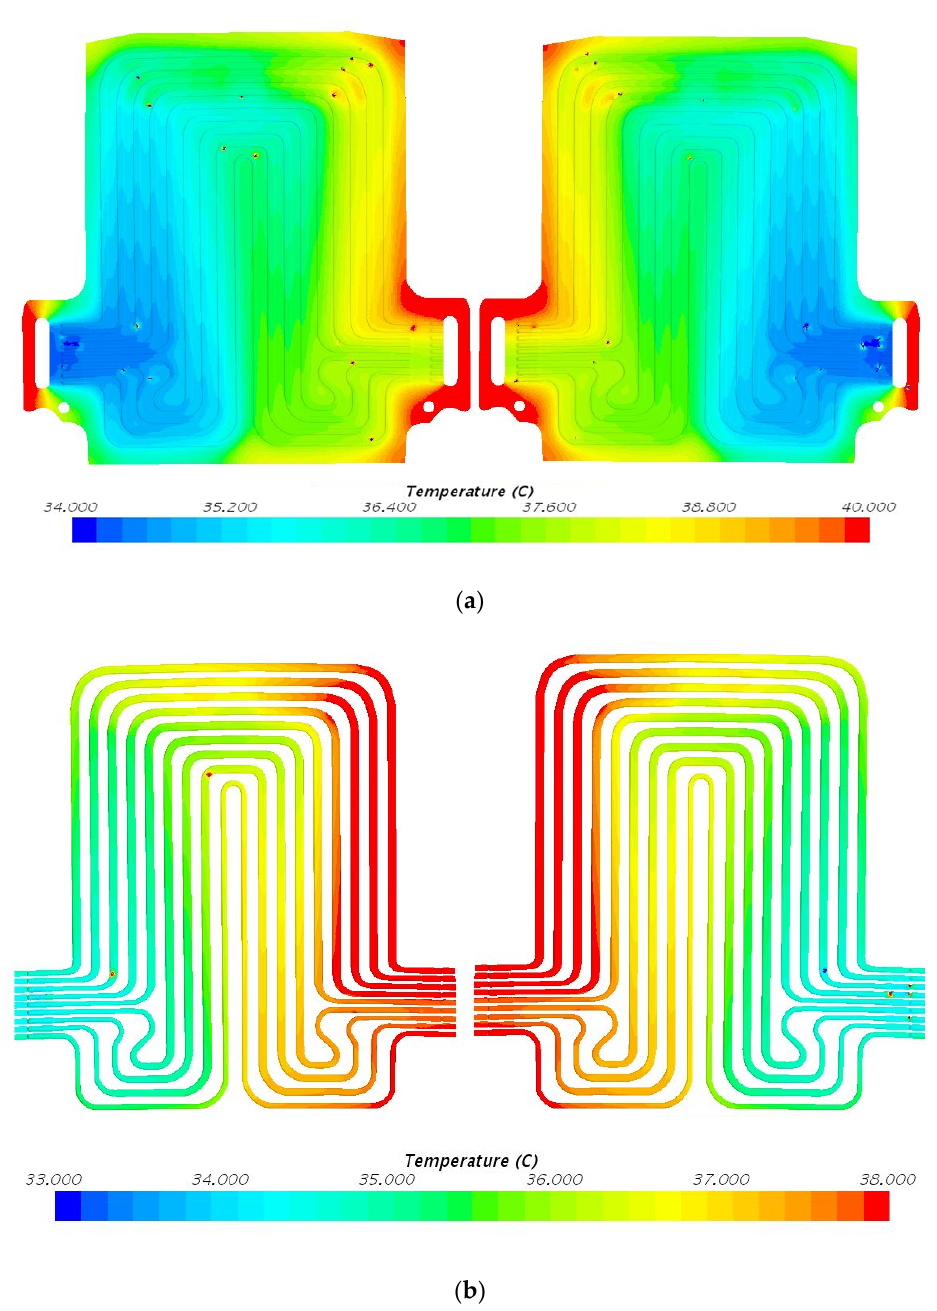
Figure 14. Temperature profile at 80 A and 35 ◦ C with heat flux values near cathode = 2160.2 W / m 2 , anode = 2101.5 W / m 2 , and mid surface = 471.8 W / m 2 . ( a ) Top view and ( b ) bottom view.